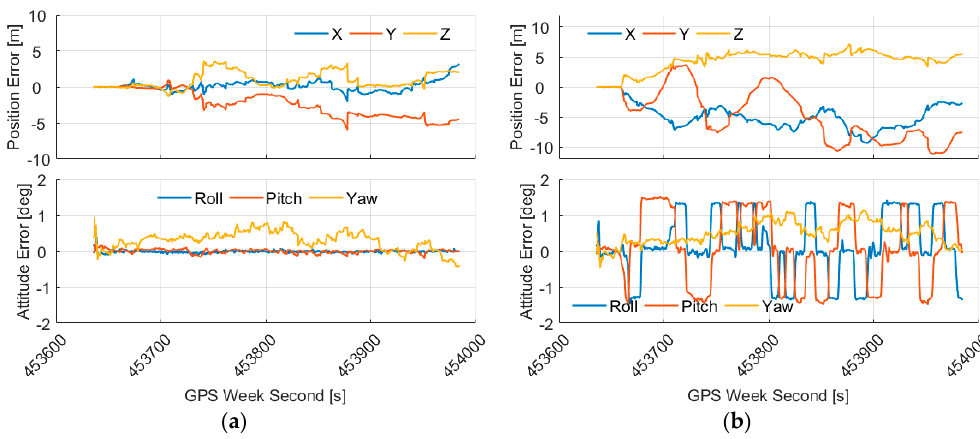
Figure 8. The RMSEs of the MTi-G-710 under 0.5-degree geodetic displacement for the sequence WRIC: ( a ) The RMSEs for Setting A, and ( b ) the RMSEs for Setting C.